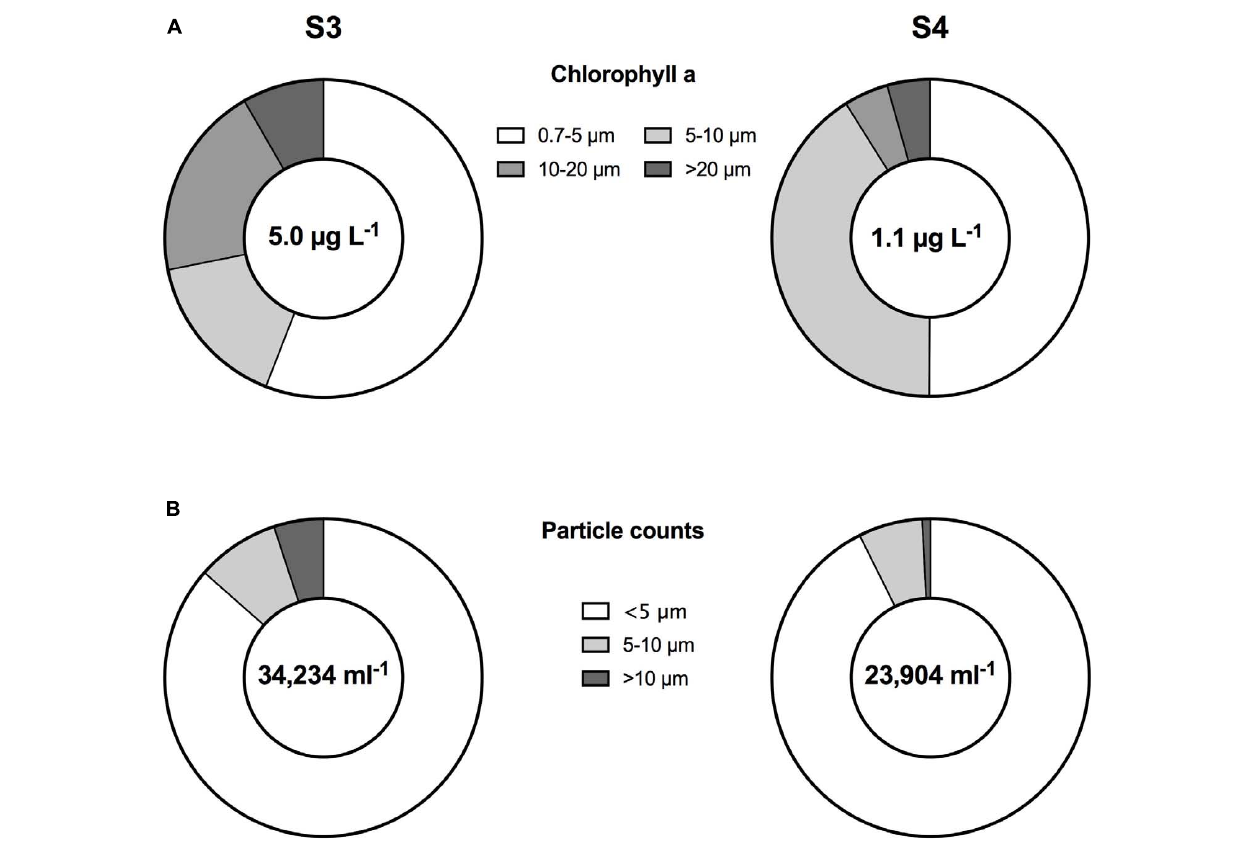
FIGURE 5 | Community structure from size-fractionated Chl a concentration (top, A ) and particle counter (bottom, B ) at two stations (S3 and S4) in the North Atlantic during May 2016. The dominance of small ( < 10 µ m) particles is revealed, as are shifts in the relative contribution of different size classes. Total Chl a and particle concentration at each station is shown at the center of the pie